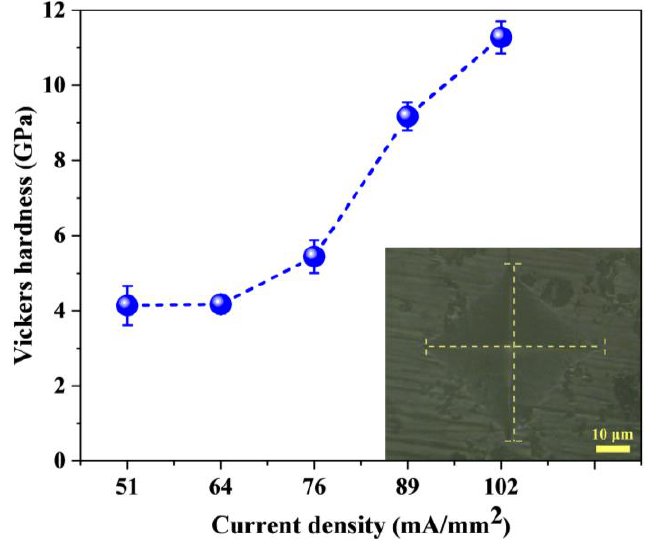
Figure 5. Influence of the current density on the Vickers hardness of 3YSZ/Al 2 O 3 composites. The inset shows the indentation patterns on the surfaces of FS-102.